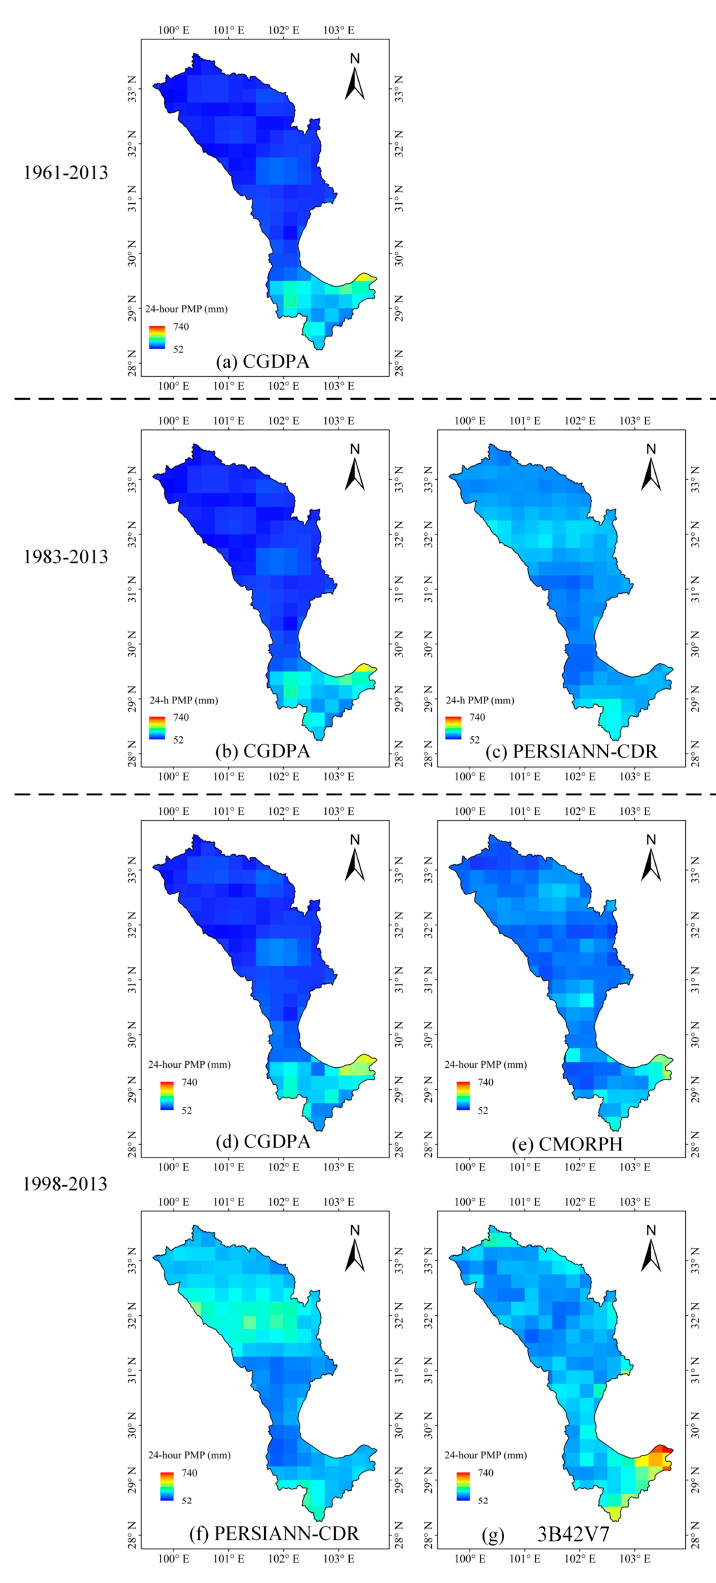
Figure 9. Spatial distribution of 24-h PMP estimation: ( a ) CGDPA of 1961–2013; ( b ) CGDPA of 1983–2013; ( c ) PERSIANN-CDR of 1983–2013; ( d ) CGDPA of 1998–2013; ( e ) CMORPH of 1998–2013; ( f ) PERSIANN-CDR of 1983–2013; and ( g ) 3B42V7 of 1998–2013.